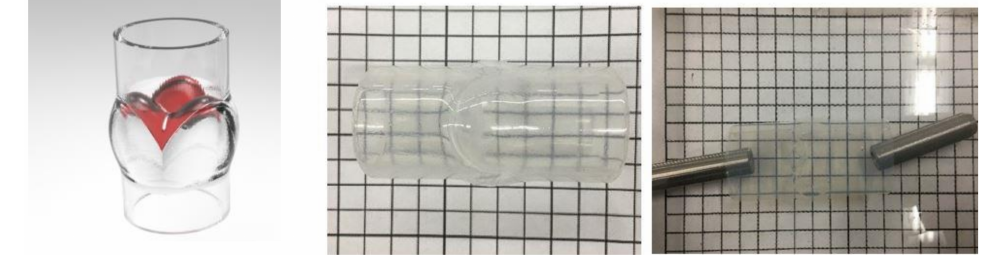
Figure 2. The silicone aortic valve model and refractive index